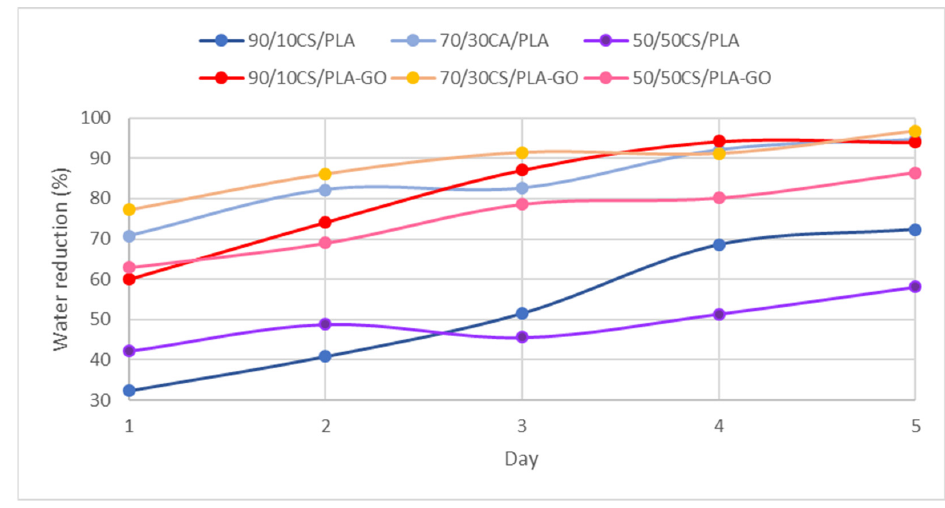
Figure 10. Percentage reduction of water absorption of CS/PLA and CS/PLA-GO composites.